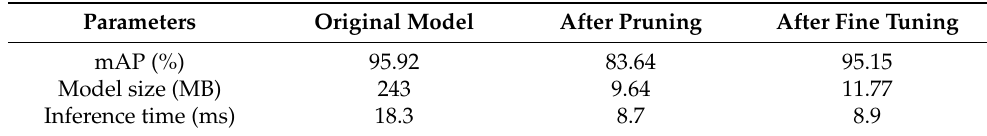
Table 5. Evaluation results before and after